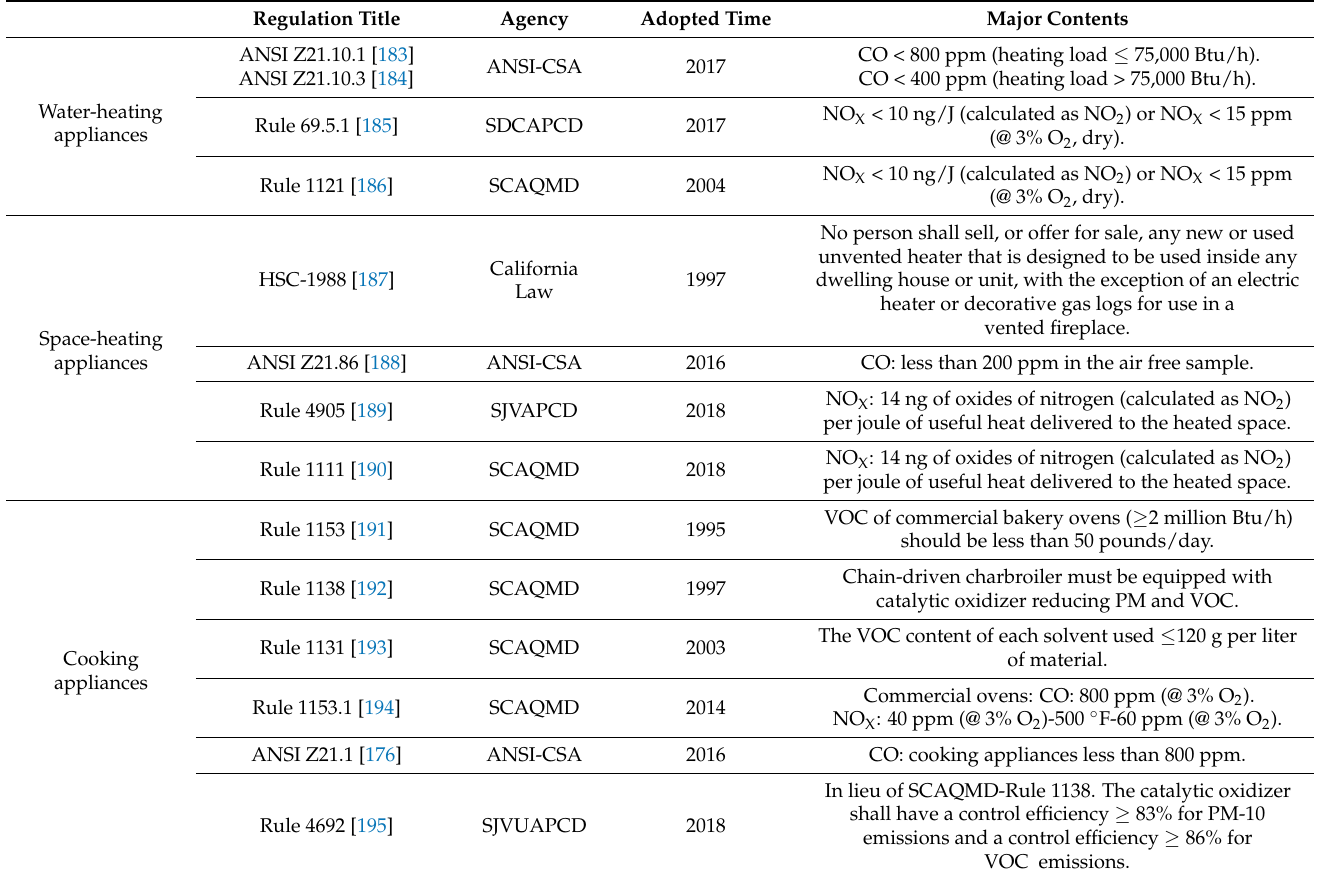
Table 16. Representative emission regulations for residential appliances in North